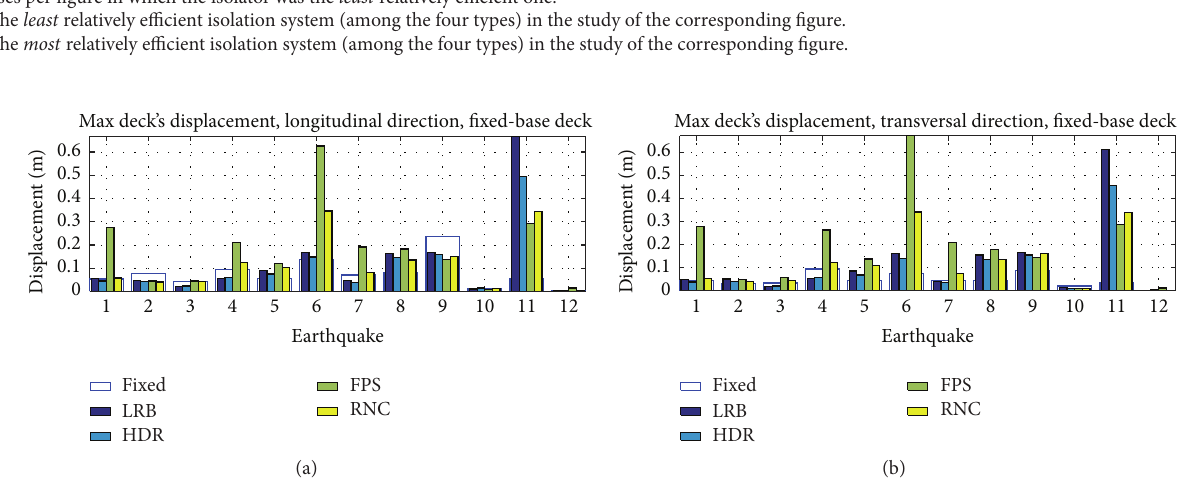
Figure 13: The deck’s peak displacements: (a) in longitudinal direction; (b) in transversal